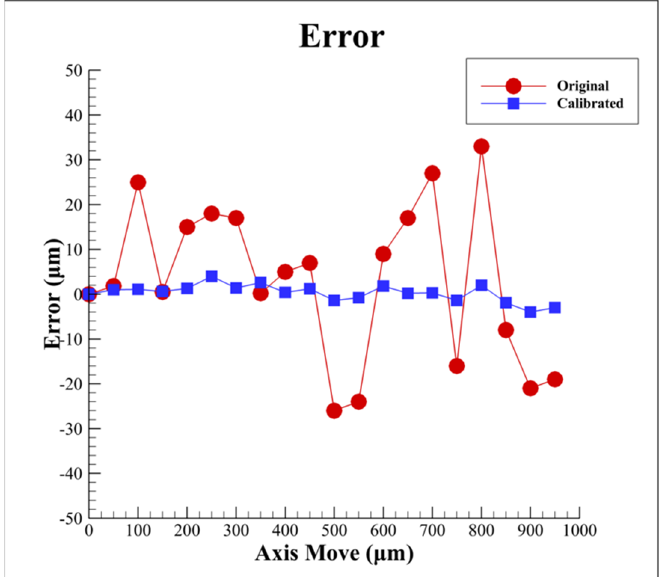
Figure 11. Experimental results for autofocusing accuracy with different defocus distances by using proposed algorithm and original distance L method, respectively.